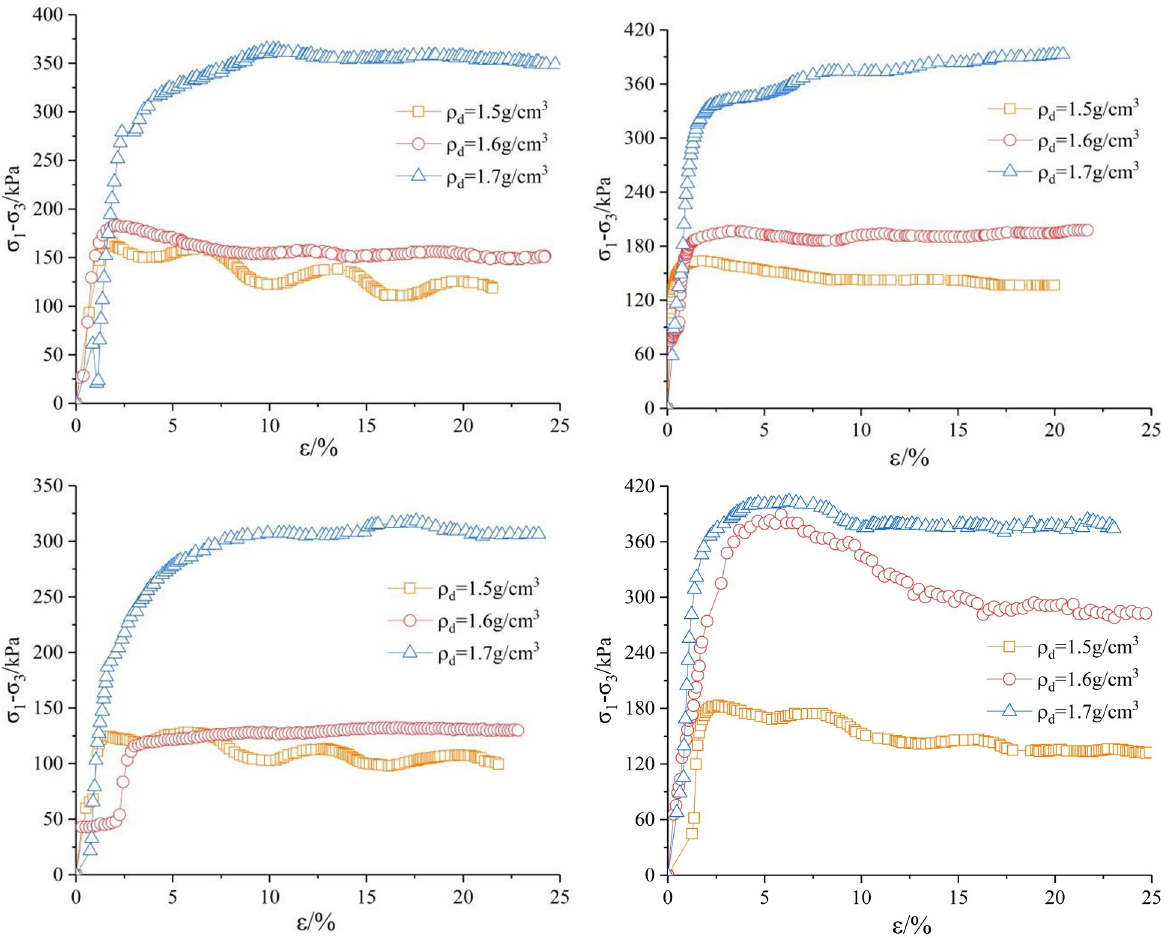
Fig 4. σ 1 -σ 3 ~ ε curve under confining pressure of 150 kPa . (a) Shear rate v = 0.04 mm/min . (b) Shear rate v = 0.08 mm/min . (c) Shear rate v = 0.16 mm/min . (d) Shear rate v = 0.4 mm/min .